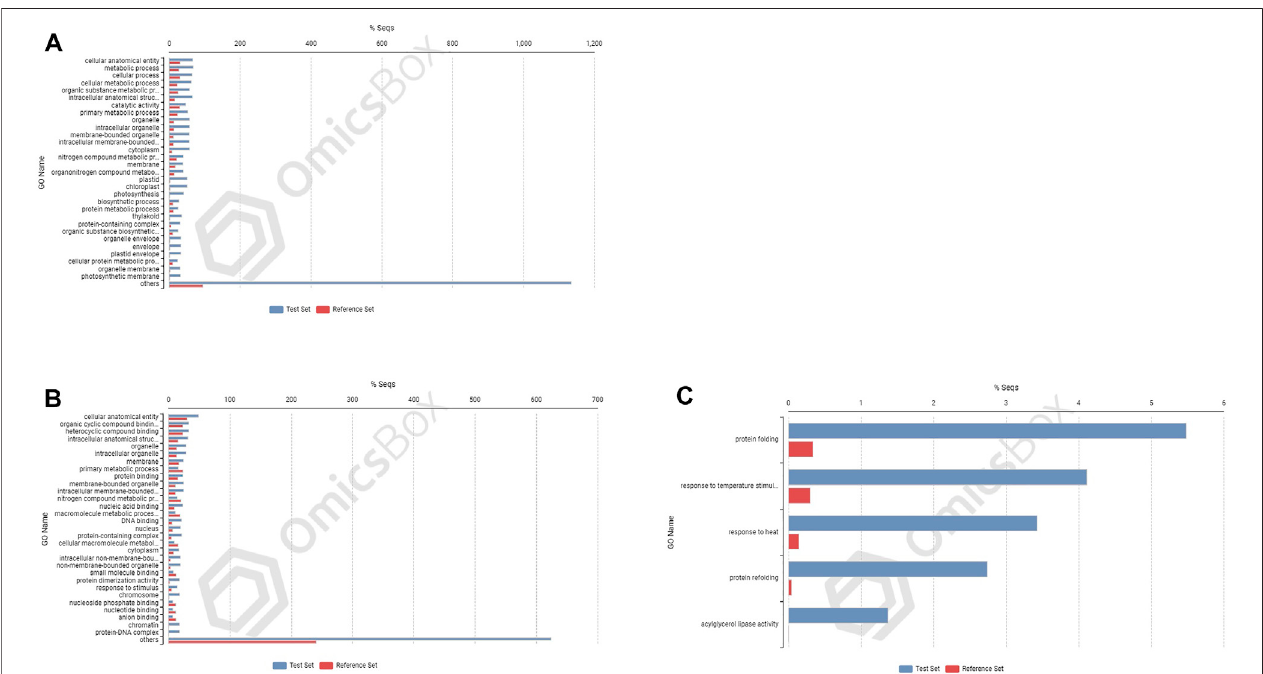
FIGURE 7 | Enrichment analysis showing genes present in roots of 703 (A) upregulated genes; and in shoot tissues: (B) upregulated and (C) downregulated.